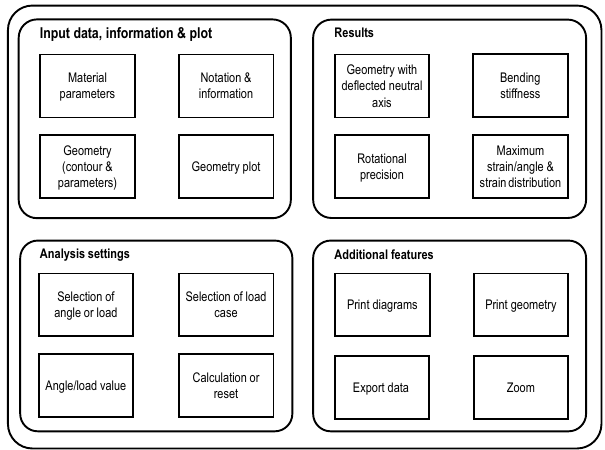
Figure 7. Modular structure of the PC program detasFLEX (Anal-